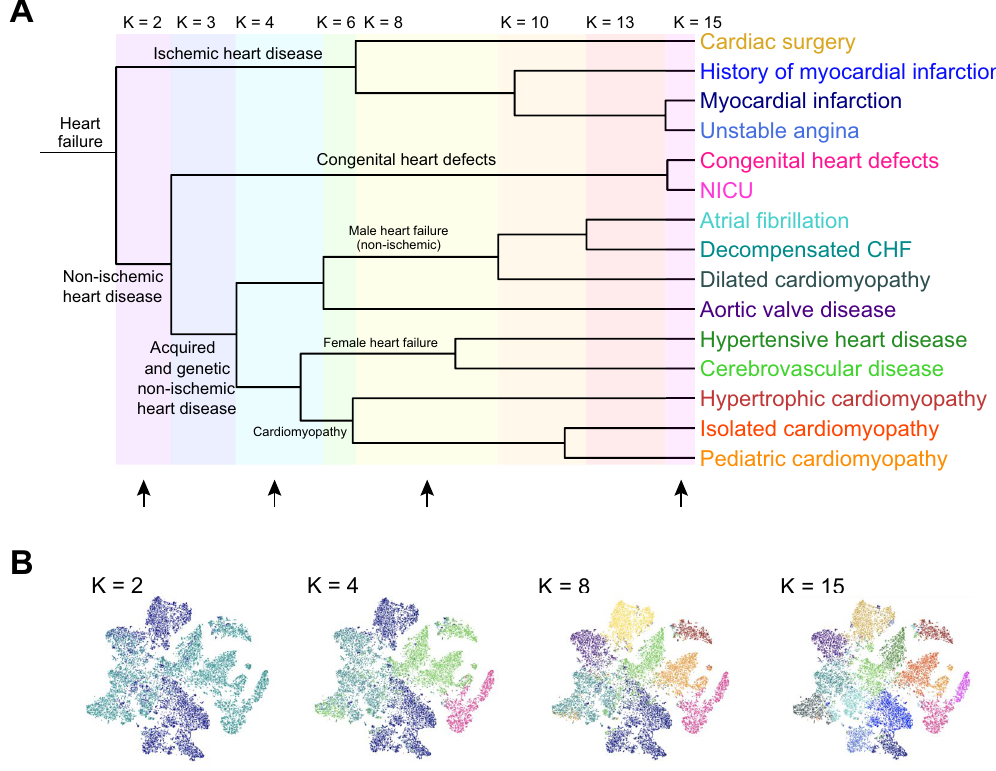
Figure 3. A data-driven hierarchy of HF classification. ( A ) Dendrogram showing hierarchical relationship between cluster phenotypes at different values of K. The dissimilarity metric used to construct distances between clusters at different levels of hierarchy was 1 – J(C i K1 , C j K2 ) , where J ( C i K1 , C j K2 ) is the Jaccard index between cluster assignment for cluster i in for K = K1 (e.g., 15) and cluster j for K = K2 (e.g., 8). Branches are labeled using a clinical interpretation of the hierarchical structure of the clusters (see discussion). ( B ) t-SNE plots showing cluster assignment for K in [2, 4, 8, 15], which are marked with black arrows in ( A